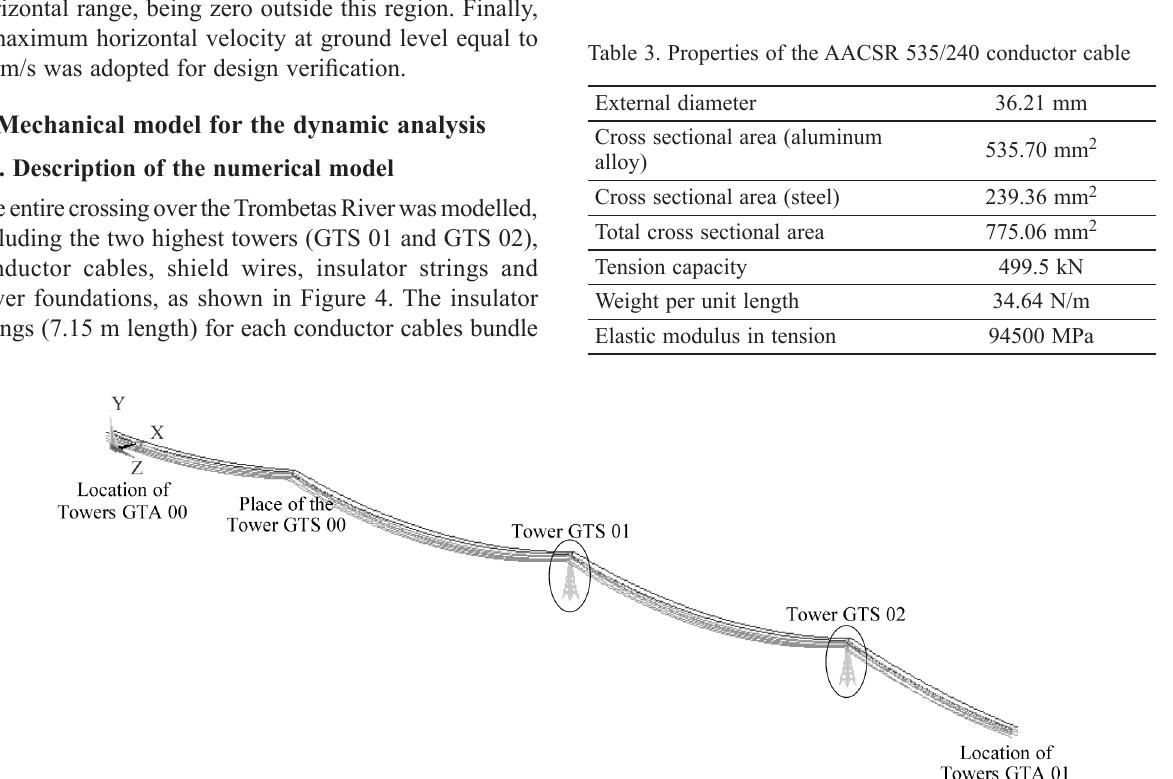
Fig. 4. Mechanical model of the crossing section over the Trombetas